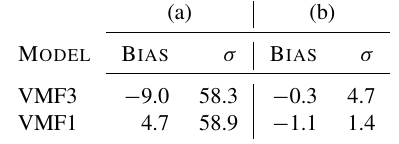
Table 4. Bias and standard deviation in slant wet delay (cid:49)L w (mm) at 5 ◦ elevation between the reference solution from radiosonde data and the other solutions. In the left part of the table (a), the zenith delays as well as the mapping functions come from the respective model; in the right part (b), the zenith delays from the radiosonde data are used for all models, so that the results reflect only the dif- ference in mapping functions. (a) (b) M ODEL B IAS σ B IAS σ VMF3 − 9.0 58.3 VMF1 4.7 58.9 − 1.1